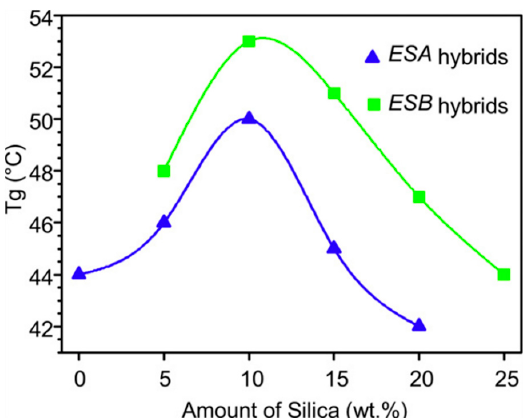
Figure 8. Changes in the glass transition temperature ( T g ) with silica content in epoxy